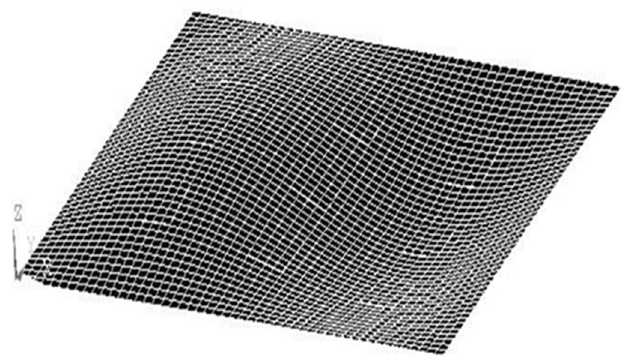
Figure 10. Periodic PZT 3 × 3 array on the composite laminate plate.